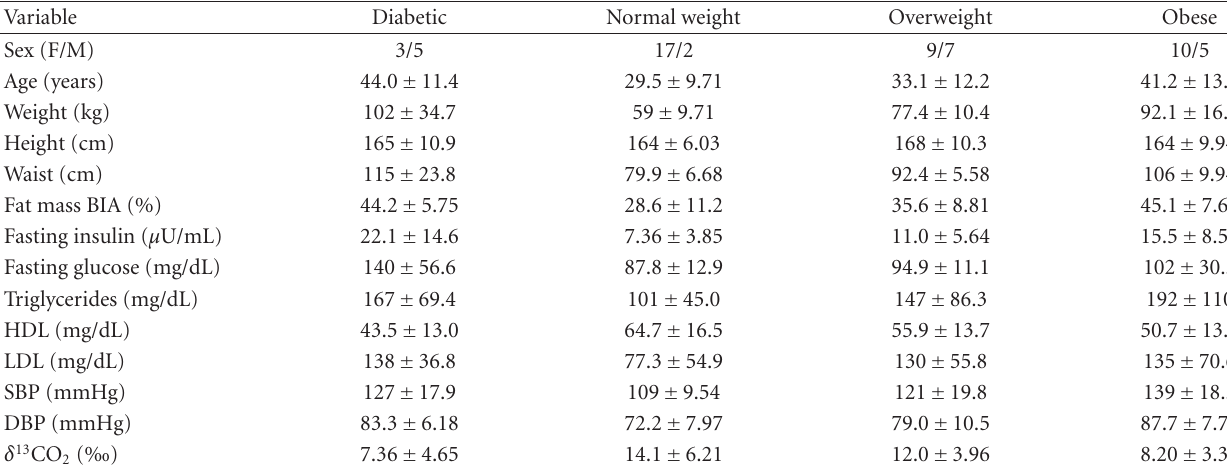
Table 1: Clinical and metabolic characteristics of study